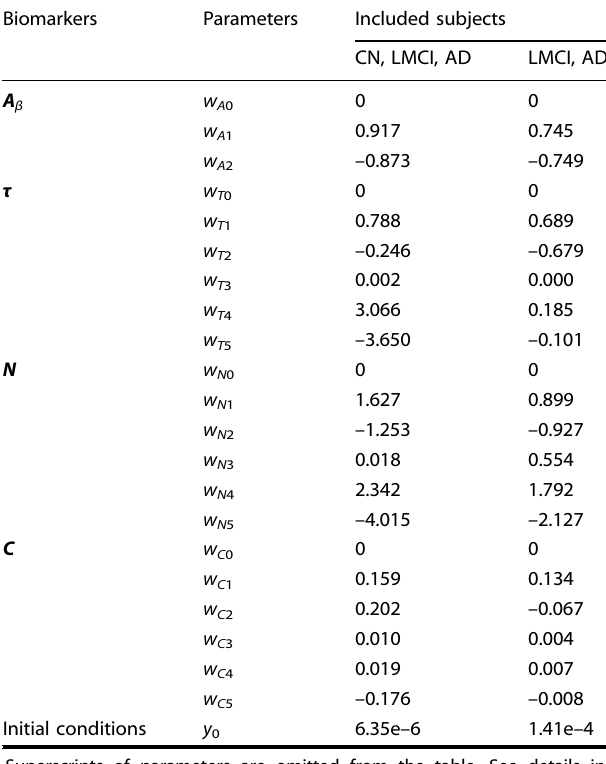
Table 1. Population parameters w (1) of the calibrated causal models based on the ADNI